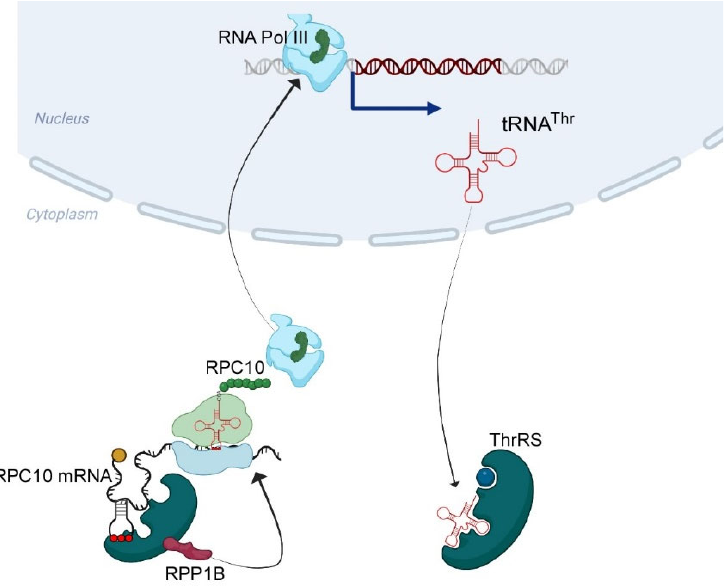
Figure 6. Suggested model for tRNA Thr expression regulation through ThrRS. Our data reveal that ThrRS binds RPC10 mRNA in an anticodon-like structure. We propose that bound ThrRS recruits RPP1B to locally mediate synthesis of RPC10 protein. RPC10 protein then binds RNA polymerase III and regulates transcription of tRNA Thr .